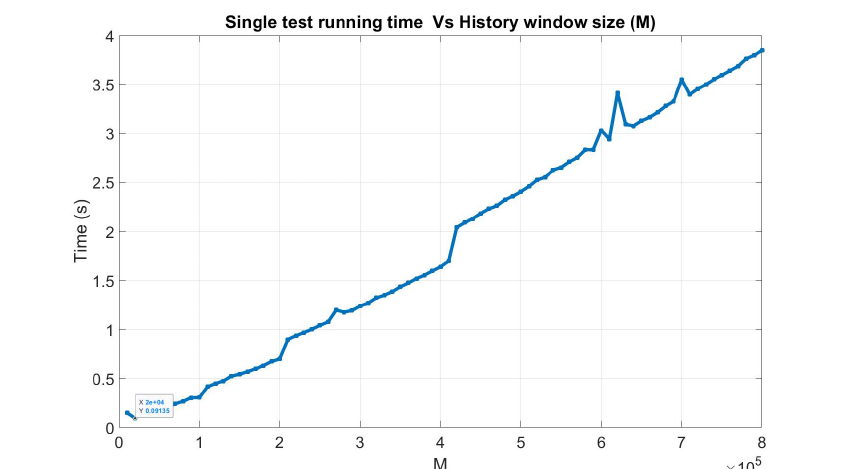
Figure 7. Algorithm running time varying the size of the history window. This example is computed running the proposed algorithm implemented in Matlab on an Intel(R) Core(TM) i3-3220 CPU